Question: Which visualization type does this figure use?
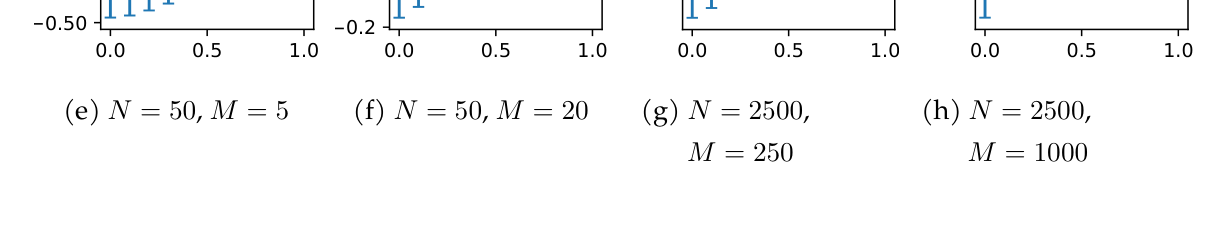
Answer: histogram